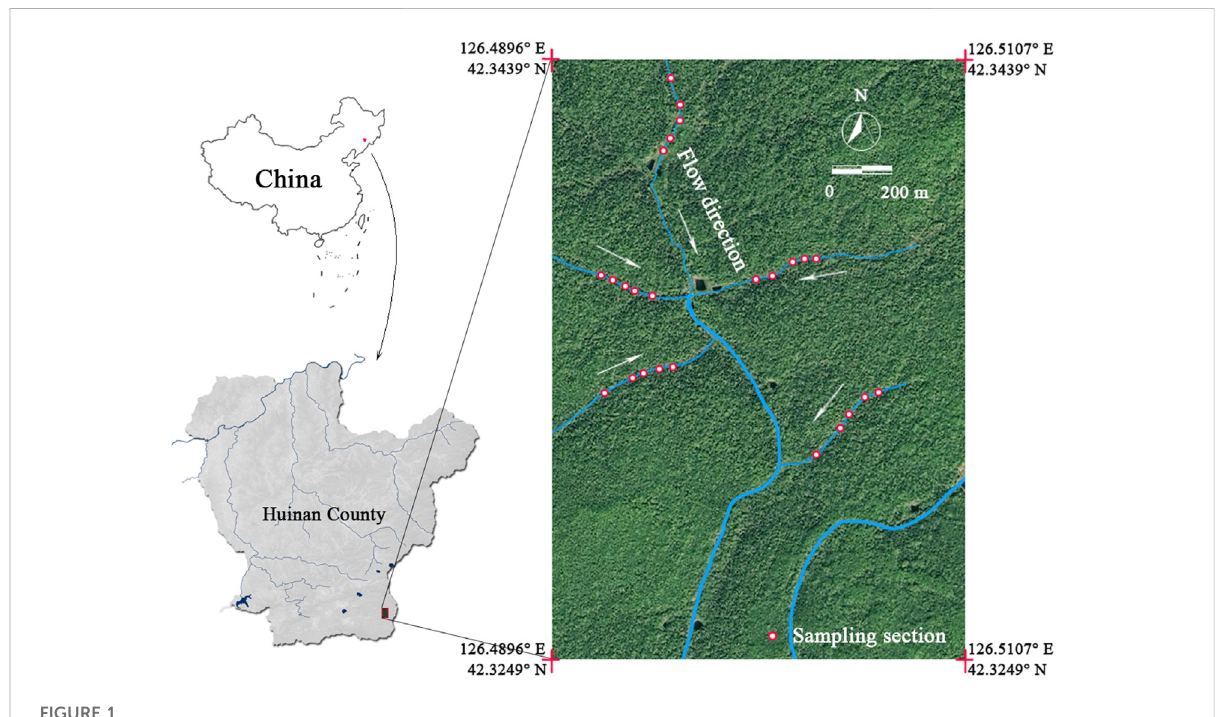
FIGURE 1 Location map of the test